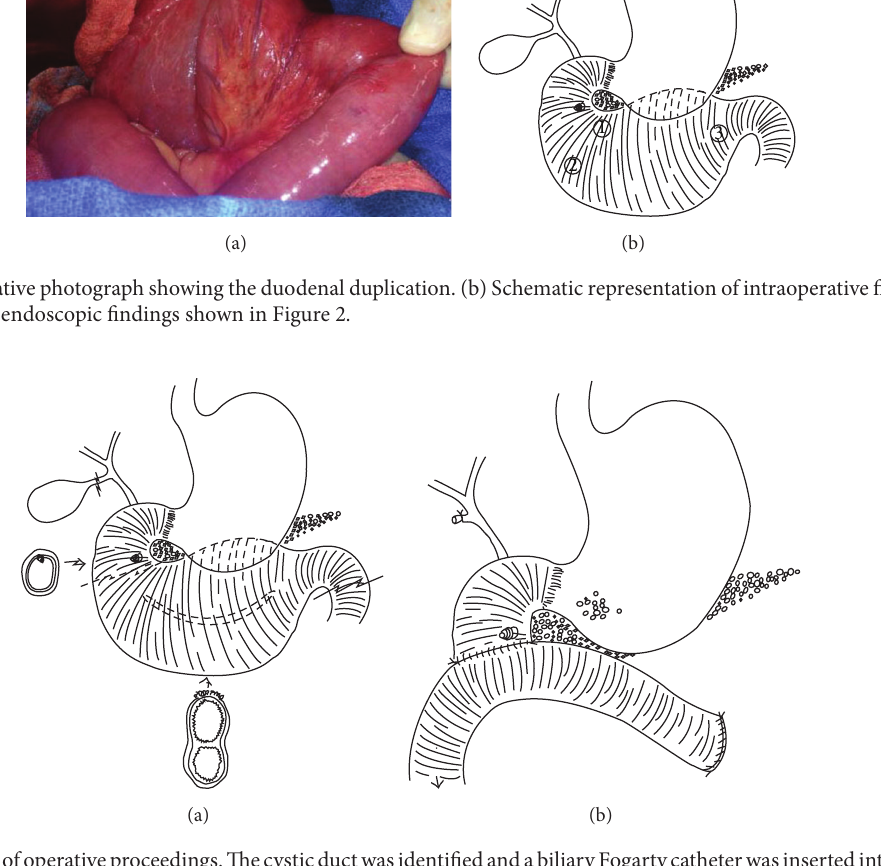
Figure4:(a)Schematicofoperativeproceedings.ThecysticductwasidentifiedandabiliaryFogartycatheterwasinsertedintotheduodenum. A duodenotomy was created and point of transection was chosen just distal to the ampulla so as to fully resect the duplication. The distal resection line occurring at the jejunum just beyond the ligament of Treitz. (b) Schematic of end-to-side duodenojejunostomy used for operative